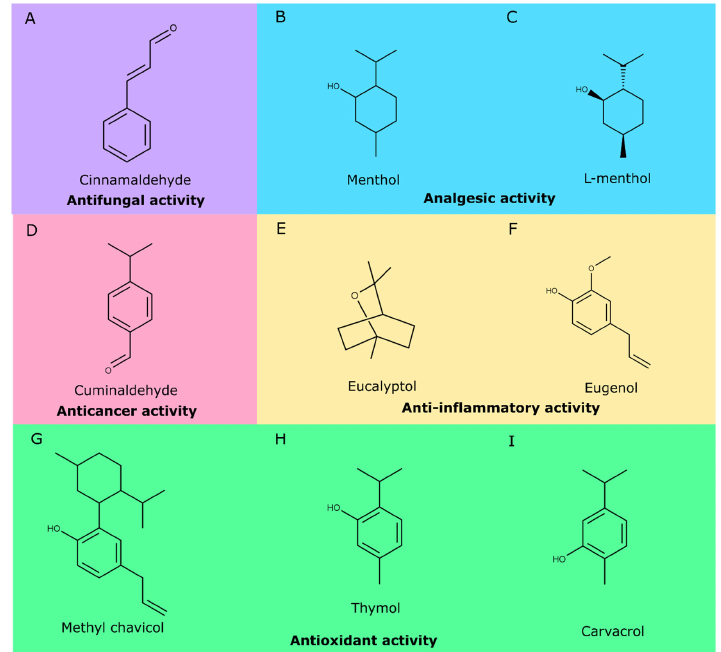
Figure 1. Natural compounds from essential oils and their reported biological activities with potential pharmaceutical